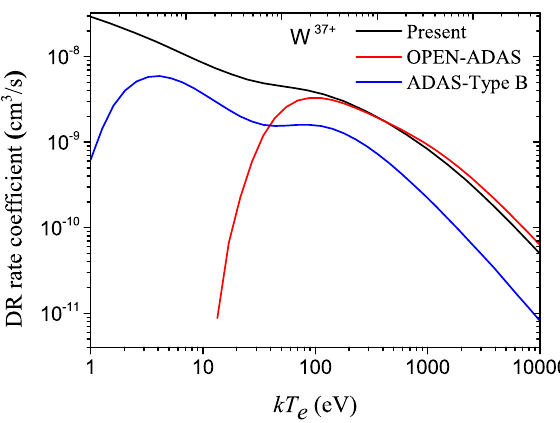
Figure 5. The presently calculated total DR rate coefficients of W 37+ ions as a function of electron energy kT , compared to available ones from the ADAS database e